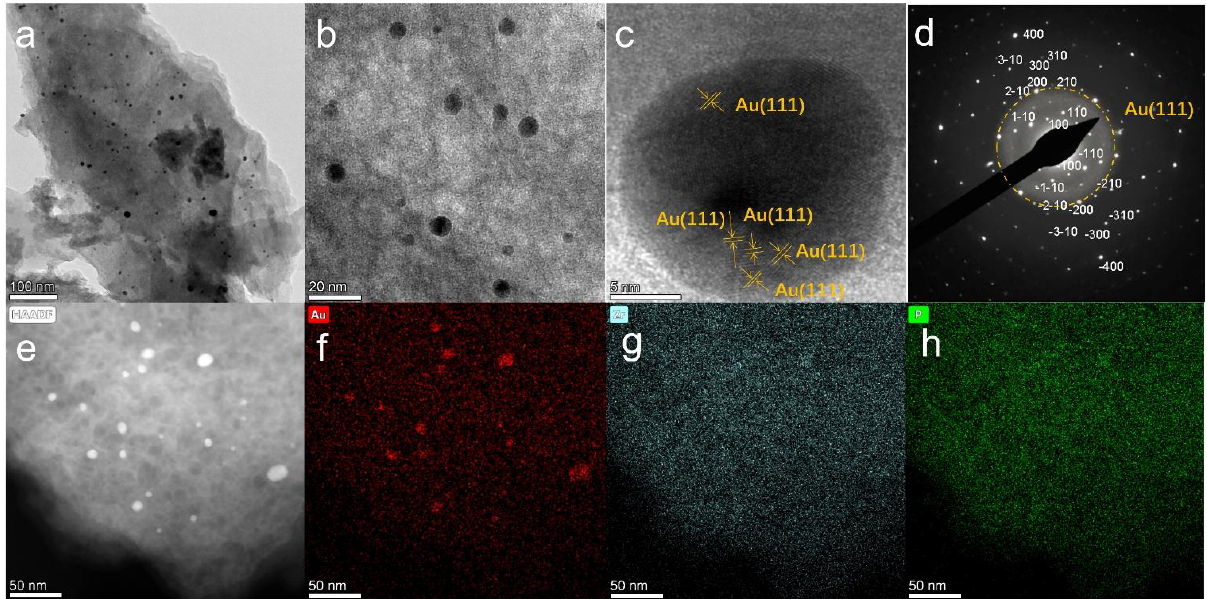
Figure 3. ( a ) – ( c ) HRTEM images, ( d ) TEM diffraction patterns, ( e ) HAADF image, and the corre- sponding EDS maps for ( f ) Au, ( g ) Zr, and ( h ) P elements of the prepared ZrP@PDA/Au.